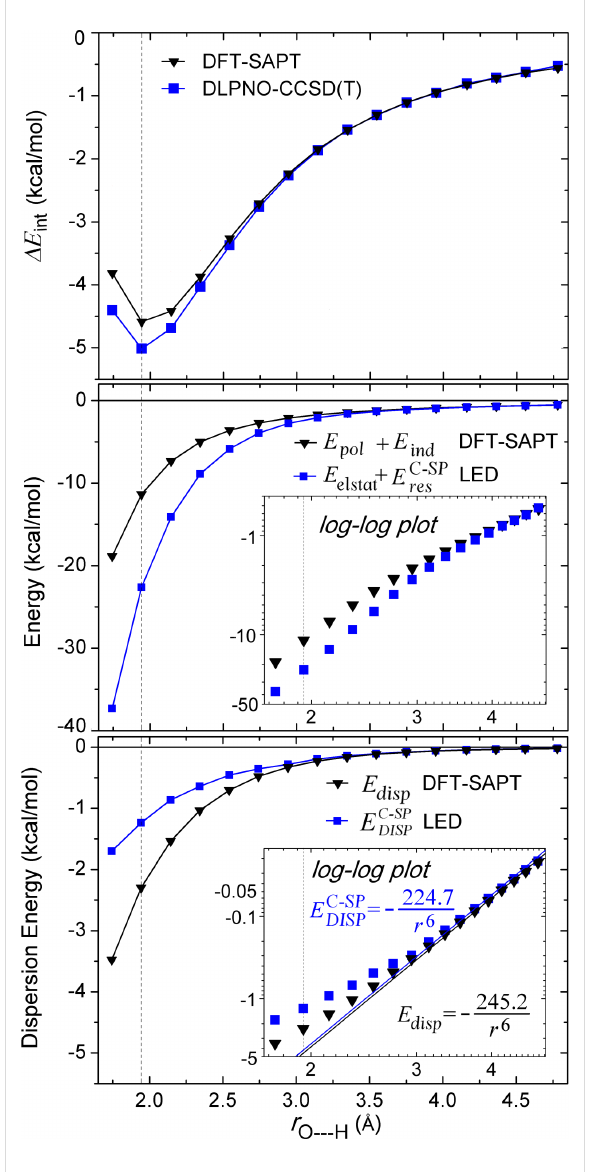
Figure 5: Comparison of total interaction, electrostatic interaction, and London dispersion energies calculated with DLPNO-CCSD(T)/LED and DFT-SAPT for Conf1 of water dimer. The black dotted vertical line at 1.943 Å corresponds to the equilibrium r e (O---H)